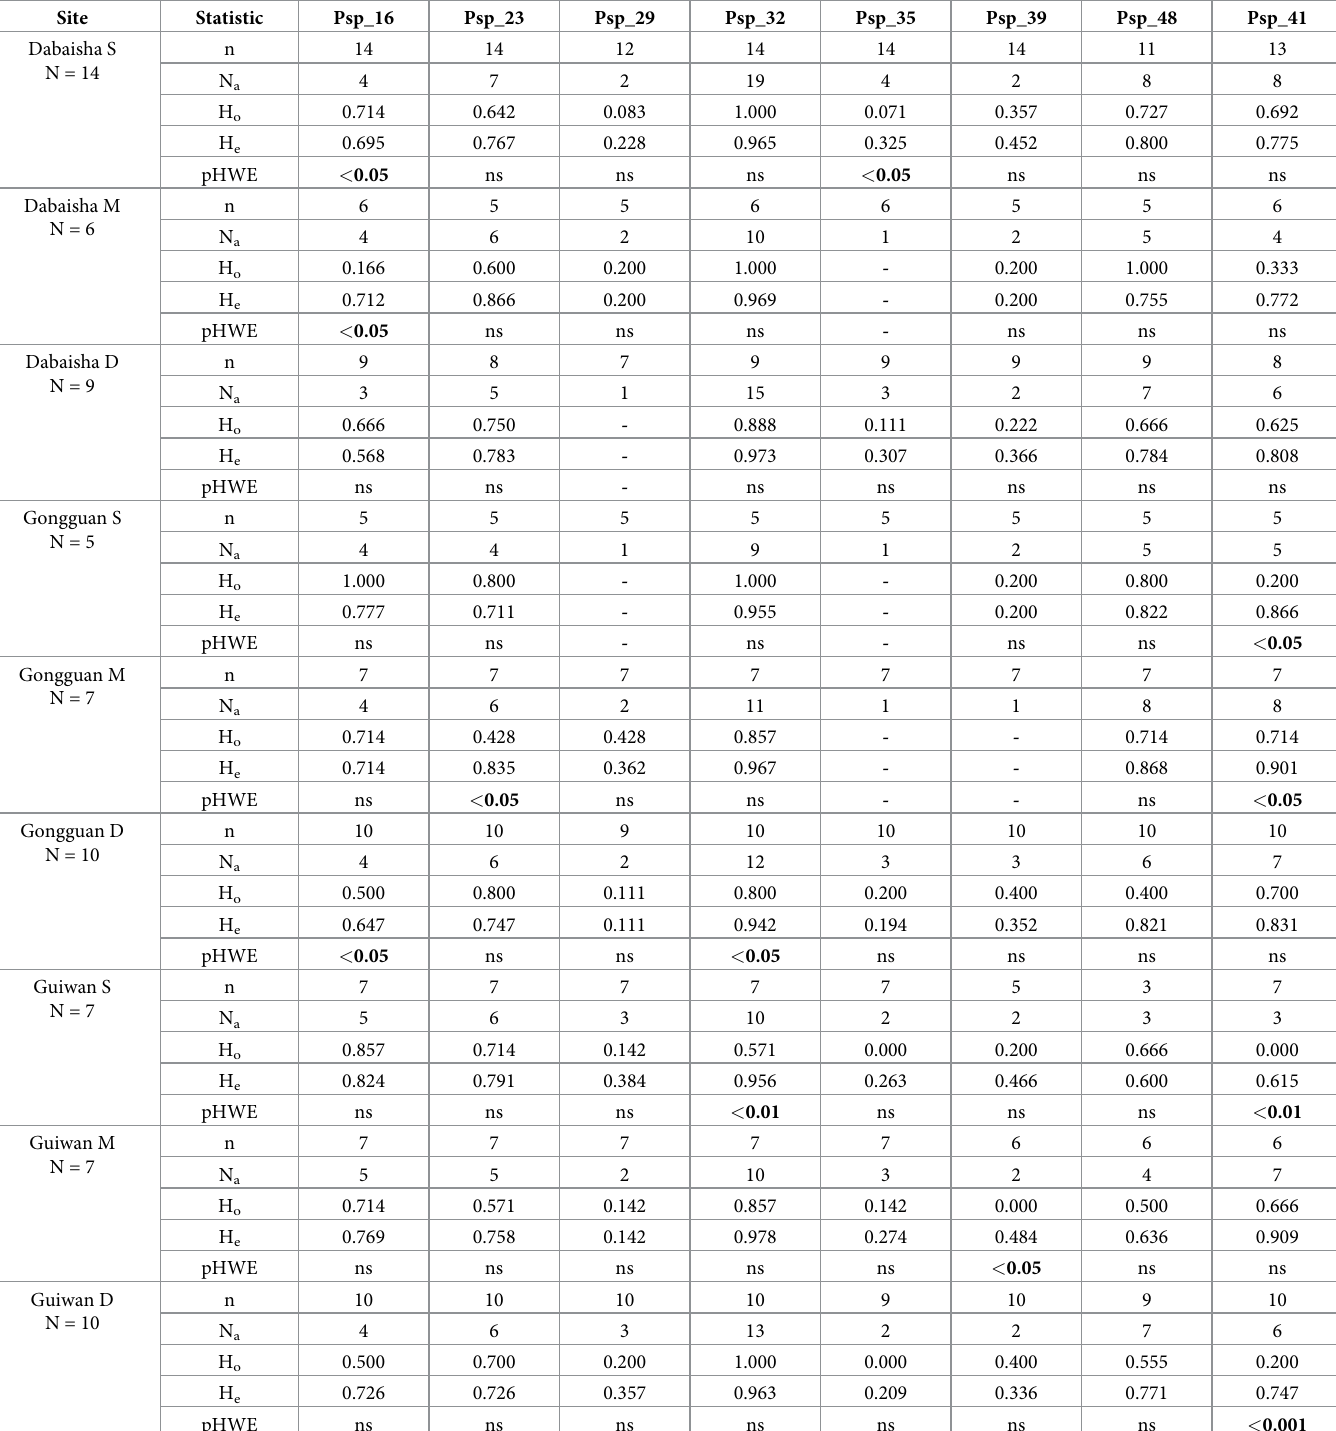
Table 2. Summary of genetic diversity statistics across loci by location. N: number of samples, n: number of specimens which produced data at each locus, N a : number of alleles, H o : observed heterozygosity, He: expected heterozygosity, pHWE: p-value for exact tests of Hardy–Weinberg equilibrium (significant values are in bold, ns for non-significant,—indicates the presence of monomorphic loci).